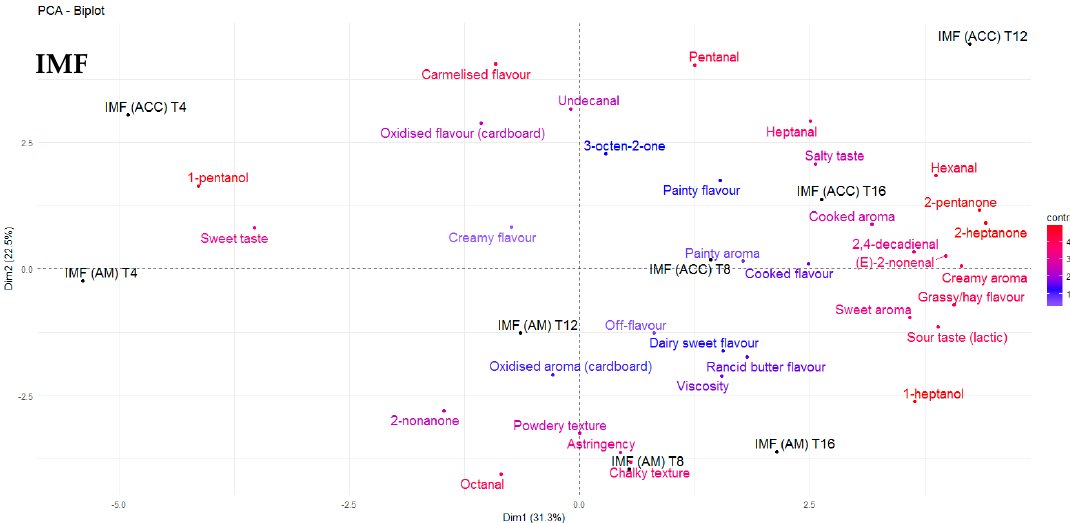
Figure 5. Principle component analysis (PCA) biplot demonstrating the correlations between the sensory perception and volatile compounds for infant milk formula (IMF) samples at T4, T8, T12, and T16 of storage. AM: ambient, 21 °C; ACC: accelerated, 37 °C.